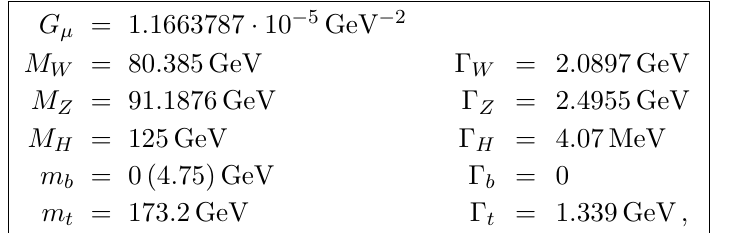
Table 2 . Values of the various physical input parameters. The value of m (cid:13)avour-number scheme as discussed in the